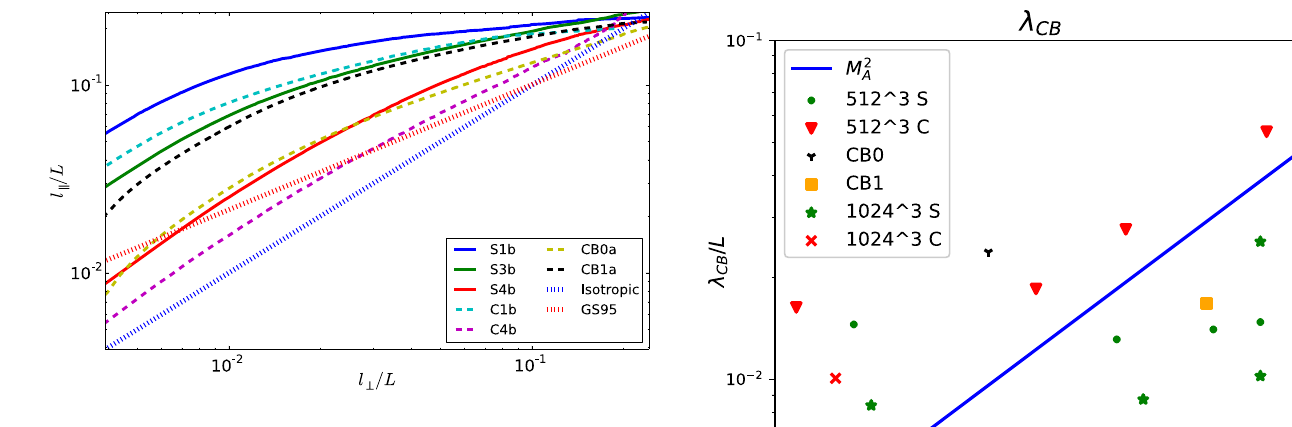
FIG. 9. The variation of l k versus l ⊥ for the slow-mode magnetic field for the different simulations. The Goldreich- Sridhar scaling is l k ∼ l 2 = 3 ⊥ , shown by the red dotted line (GS). Isotropic behavior l k ¼ l ⊥ is shown by the blue dotted line.